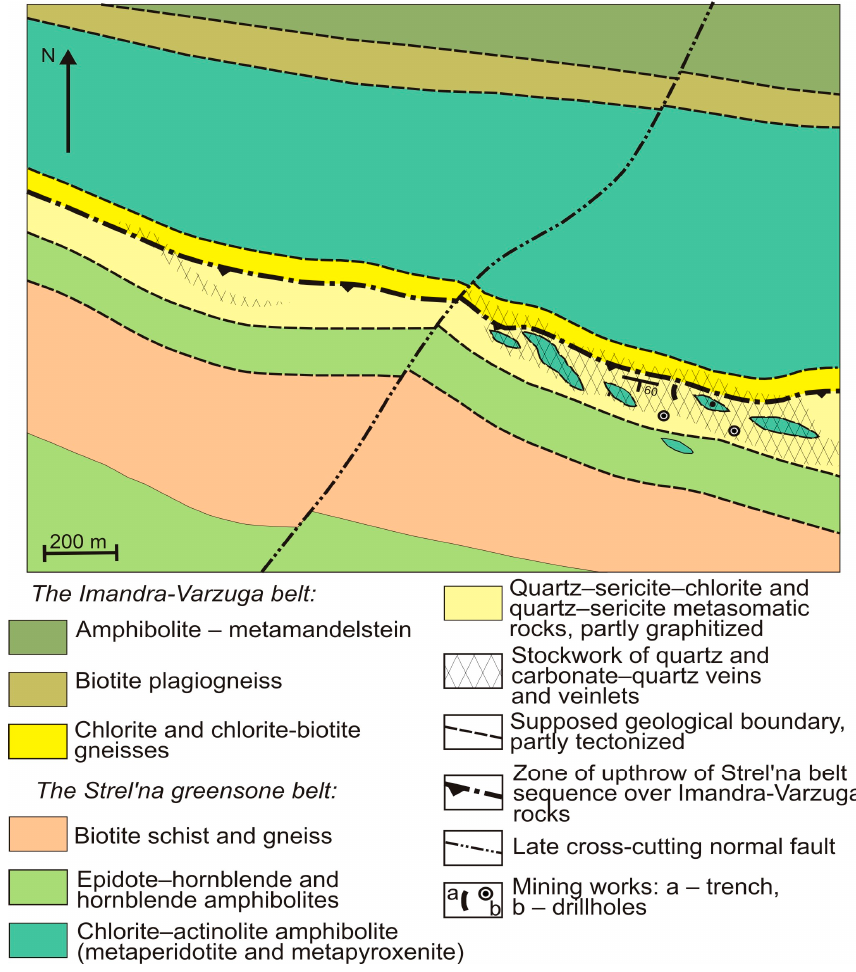
Figure 11. Schematic geological map of the Vorgovy gold occurrence.